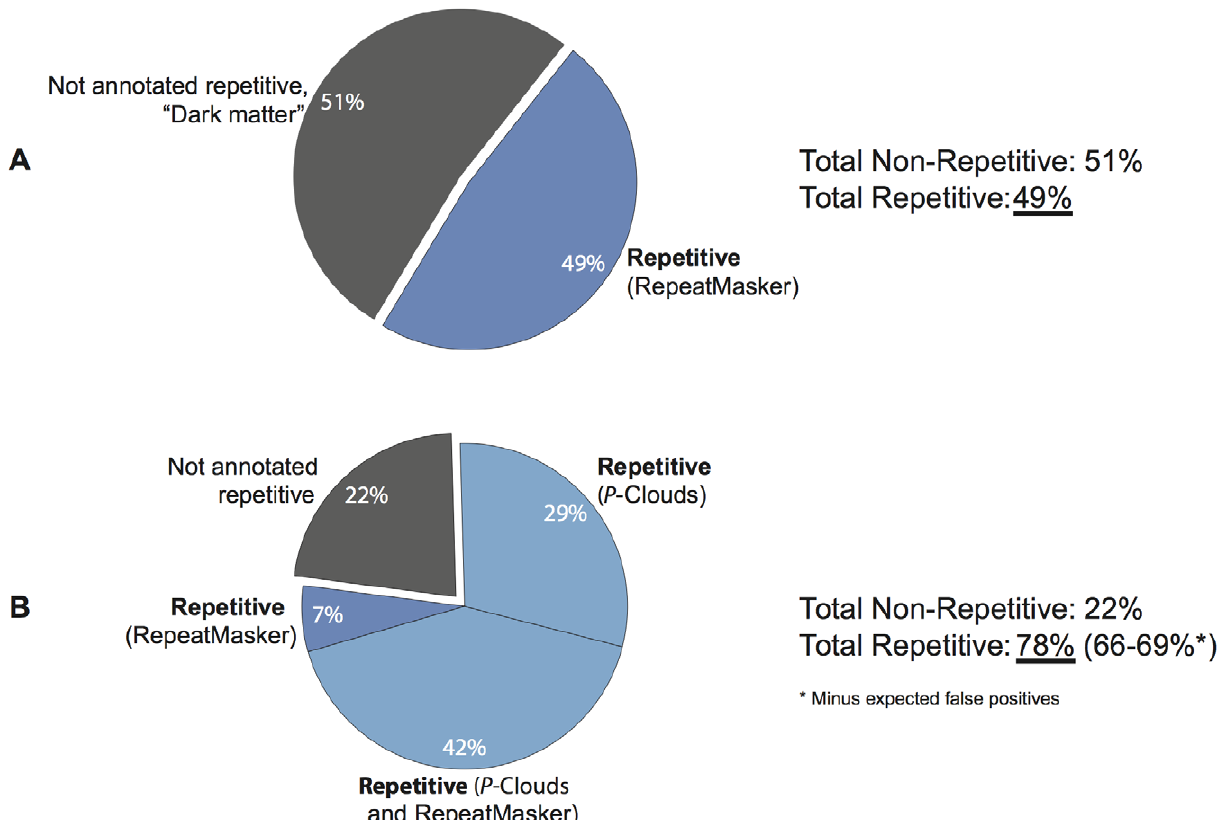
Figure 2. P -clouds and RepeatMasker annotation of the repeat structure of the human genome. Results are displayed as a percentage of the ungapped genome assembly length. A) Consensus results prior to this study indicate that , 50% of the genome is repetitive ( RepeatMasker ). B) Analysis using P-clouds suggests more than two-thirds of the genome is repetitive or repeat-derived.